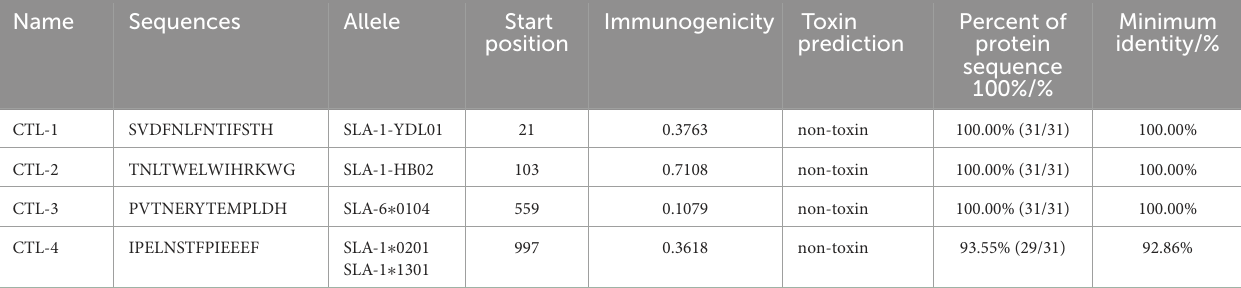
TABLE 3 Candidate CTL cell